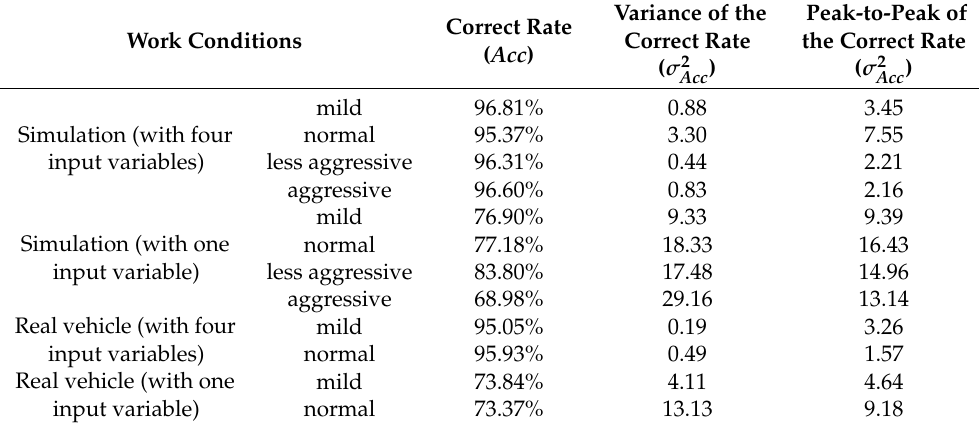
Table 2. Recognition